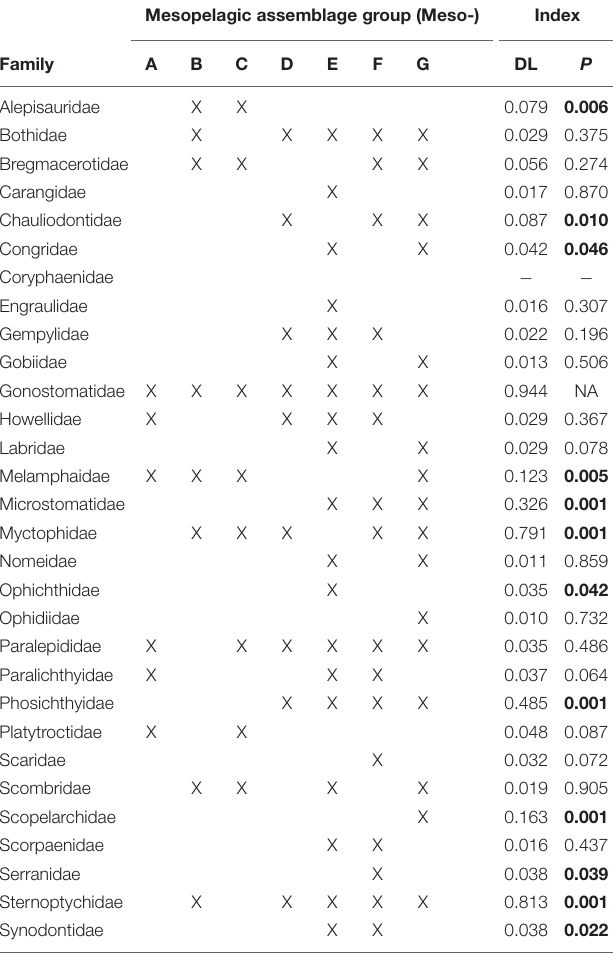
TABLE 3 | Dufrêne-Legendre (DL) indicator values characterizing the association of larval fish families with mesopelagic assemblage groups (or combinations of assemblage groups) following De Cáceres et al.